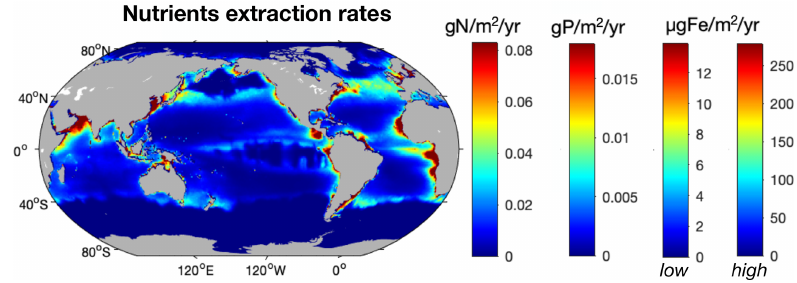
Figure 7. Distribution of the modeled amount of N (gNm − 2 yr − 1 ), P (gPm − 2 yr − 1 ), and Fe (µgFem − 2 yr − 1 ) extracted from the ocean at the time of the global peak catch. The two color bars for Fe represent the low and high estimates based on the 95% confidence interval for Fe:C values in fish (10–200µmolFe(molC) − 1 ). Table 4. Table of values in LMEs from the model ensemble simulations in the pristine state and at the global peak catch. This table contains integrated values of the amount of nutrients removed by fishing in LMEs (Tgyr − 1 ) and the ranges of values of the global nutrient inputs to the ocean from the literature (Tgyr − 1 ). N P Fe (low estimate) Fe (high